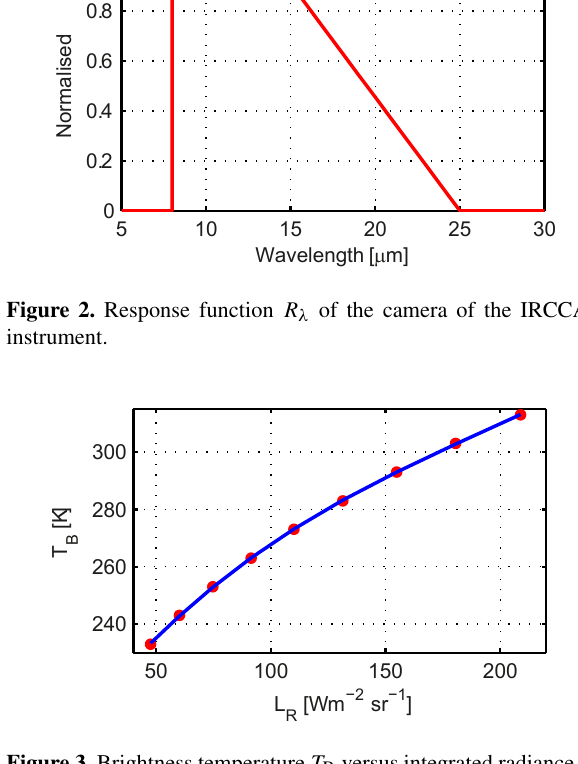
Figure 3. Brightness temperature T B versus integrated radiance L R for different radiance values (red dots), and the corresponding third- order polynomial fitting function (blue